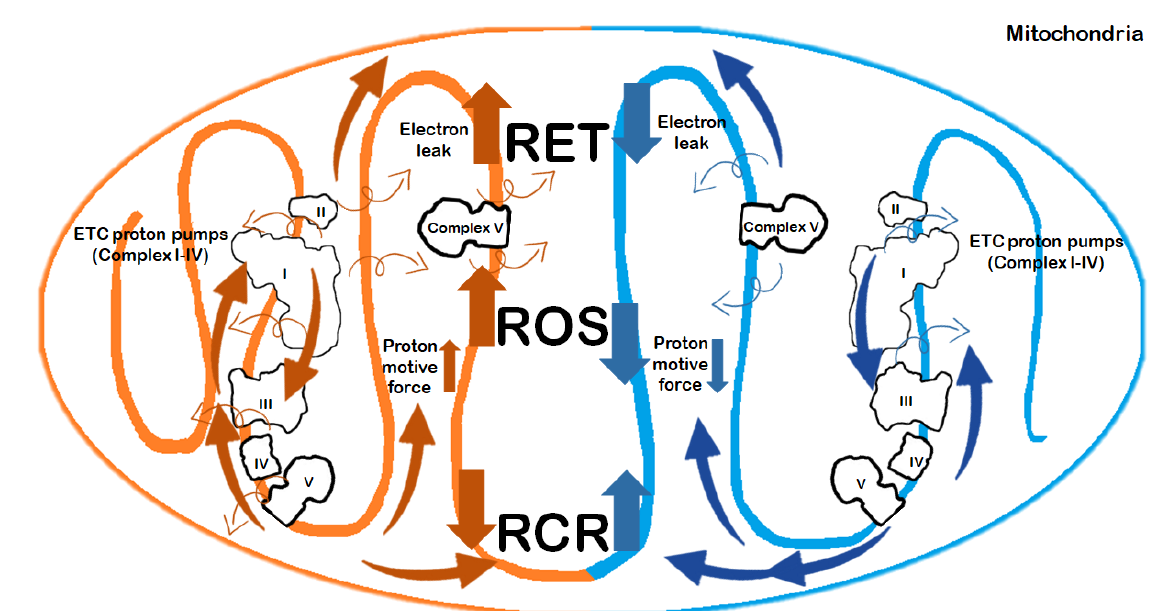
Figure 9. Changes in mitochondrial functions in warm and cold ischemia. Warm and cold ischemic changes are shown on the left and right side of the figure, respectively. Ischemia impairs complex V (ATP synthase). This indicates that electron transport is not coupled to ATP synthesis, and was decreased in response to prolonged preservation (SCS ≥ 12 h). The electron leak at mitochondrial complex I at the onset of reperfusion is the main source of oxidative stress [17]. The mechanism is initiated by the ischemic accumulation of the tricarboxylic acid (TCA) cycle metabolite succinate, which fuels the reverse electron transfer (RET) toward complex I, thereby leading to the production of reactive oxygen species (ROS) [14]. These findings raise the possibility that impairment of mitochondrial function may be an underestimated contributor to the compromised liver graft function after transplantation.